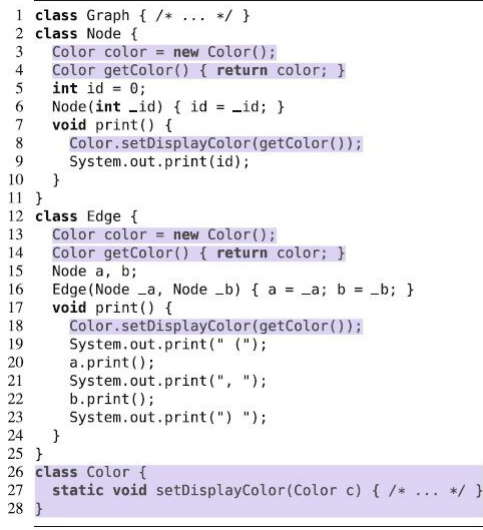
Figure 5: Code of FOP solution of feature